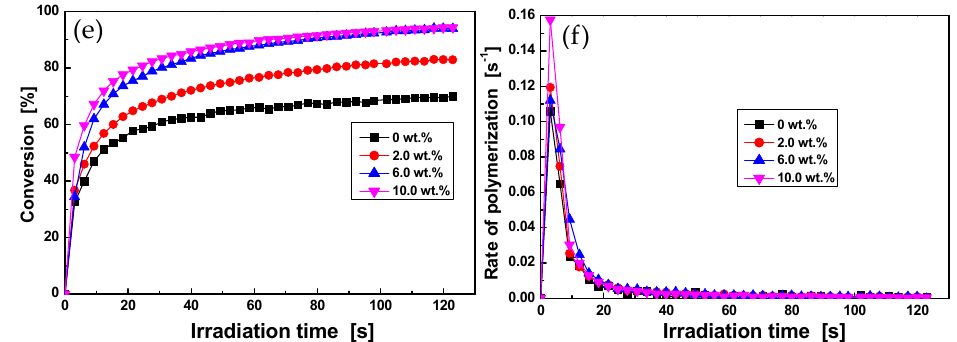
Figure 3. Effect of light intensity and dosage of photoinitiator on photopolymerization kinetics of FHBPUA and UV1000 resin; ( a ) double bond conversion and ( b ) rate of photopolymerization as a function of irradiation time with 4.0 wt % Irgacure 1173 under different light intensities; ( c ) double bond conversion and ( d ) rate of photopolymerization as a function of irradiation time under 30 mW/cm 2 with various dosage of Irgacure 1173; ( e ) double bond conversion and ( f ) rate of photopolymerization of UV1000 resin containing different dosage of FHBPUA as a function of irradiation time with 4.0 wt % Irgacure 1173 and 30 mW/cm 2 light intensity.